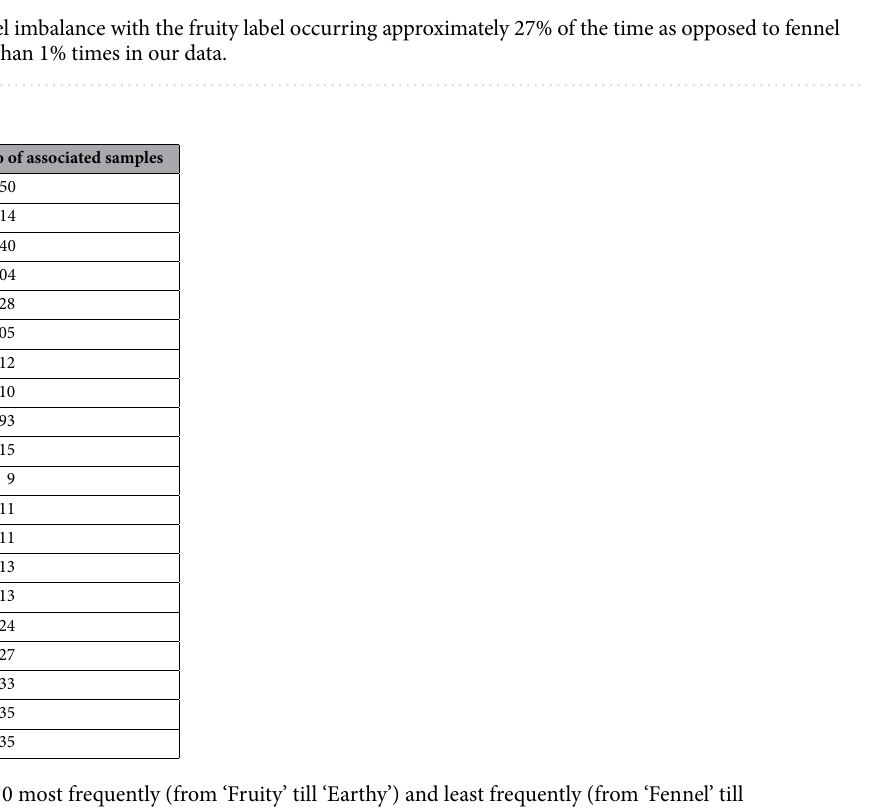
Table 1. Top 10 most frequently (from ‘Fruity’ till ‘Earthy’) and least frequently (from ‘Fennel’ till ‘Watery’) occurring Odors